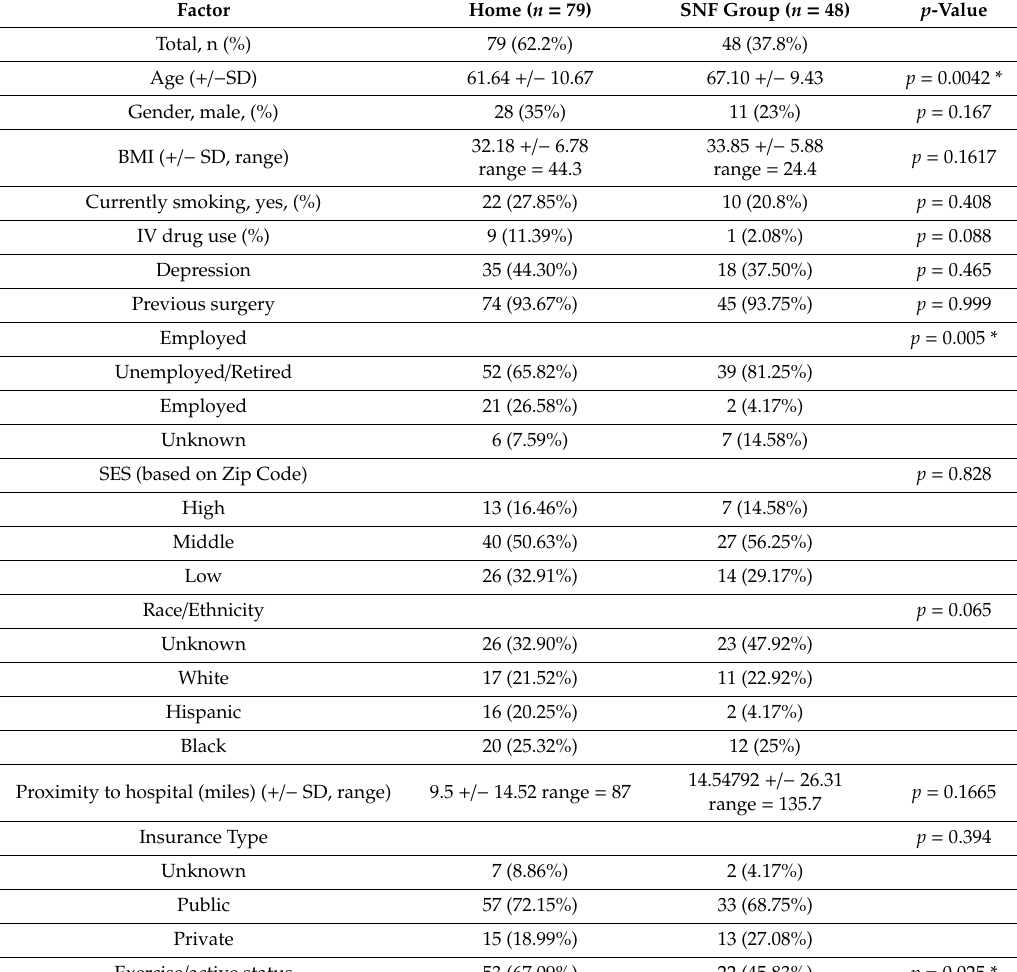
Table 1. Factors for patients living alone discharged to home or skilled nursing facility following